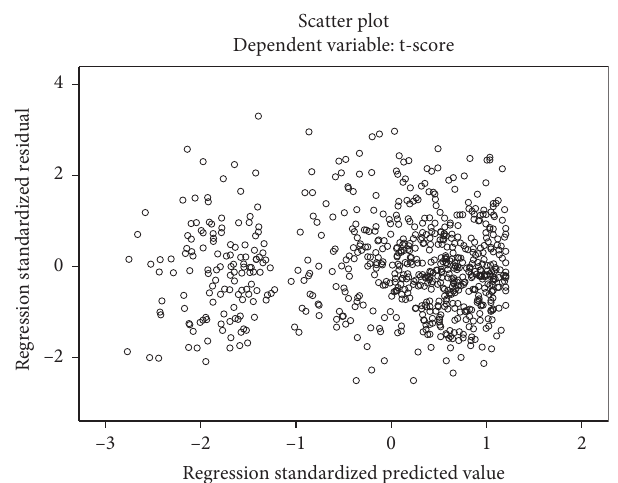
Figure 1: Scatter plot for the academic burnout prediction